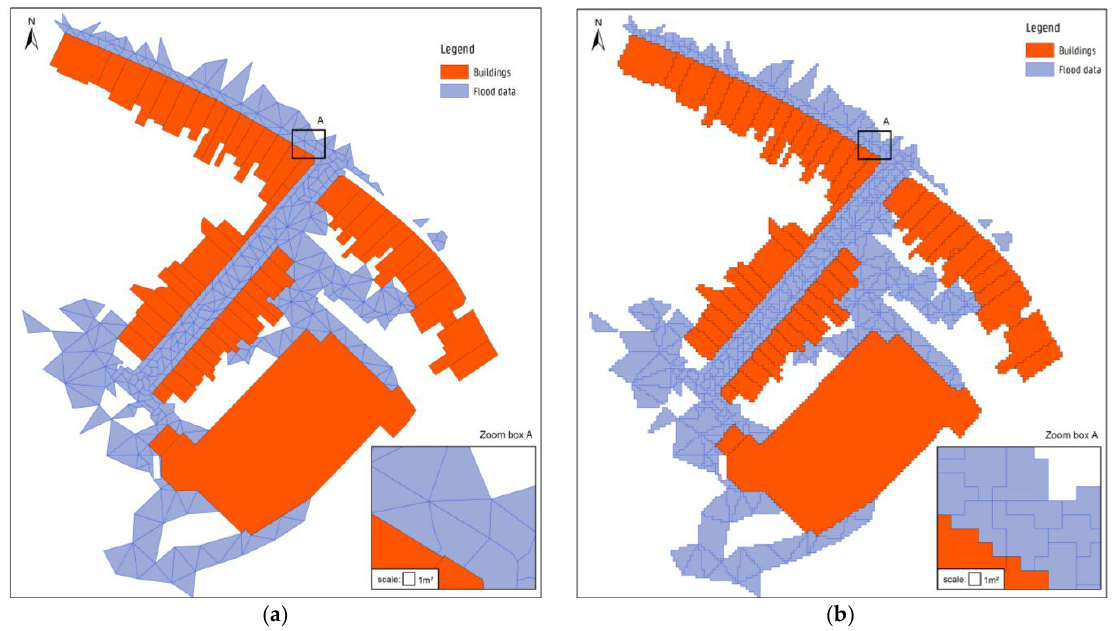
Figure 5. After converting unstructured mesh-based flood data ( a ) into raster-based flood data ( b ), there is no overlap of grid cells of the flood data with the object.